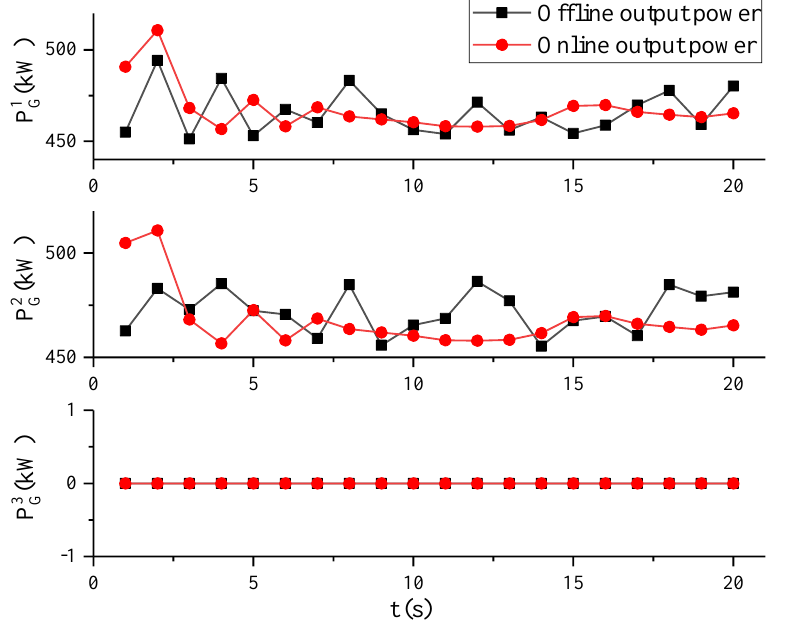
Figure 12. Comparison of offline and online